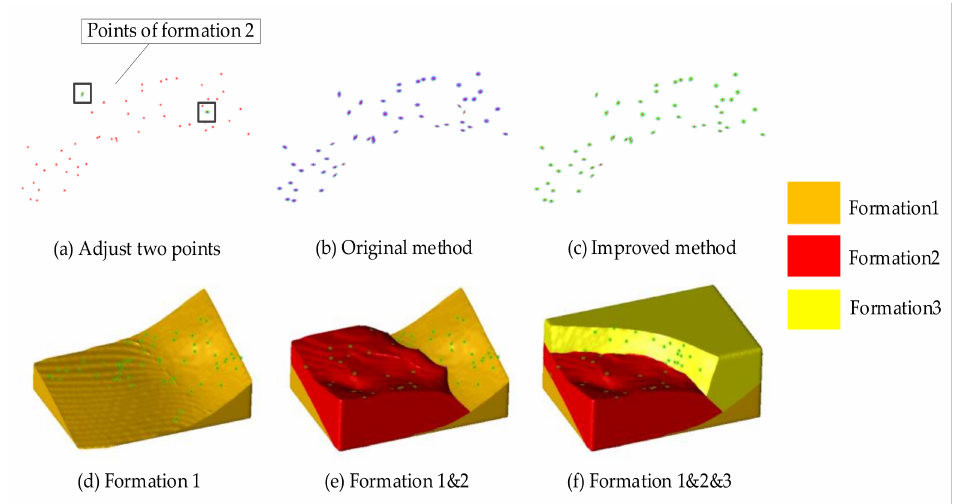
Figure 11. Normal estimation and modeling results of the fourth data set. ( a ) shows that the normal directions of the two points have been adjusted artificially. ( b ) is the normal estimation result obtained by using the original method. ( c ) is the normal estimation result obtained by using improved method in this paper. ( d – f ) shows the geological modeling results obtained by using modeling method in this